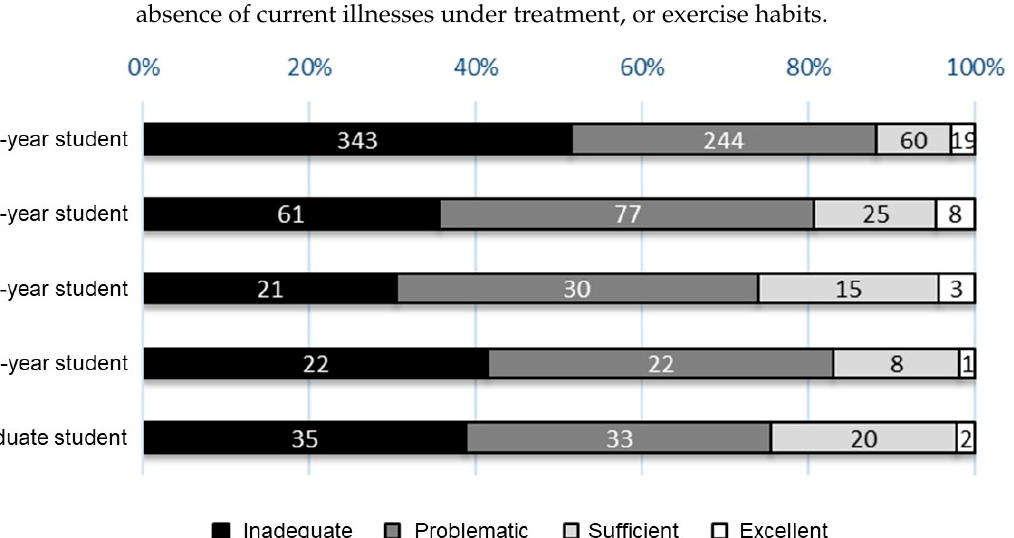
Table 3. Mean scores of each competency across the three domains of the HLS-EU-Q47.